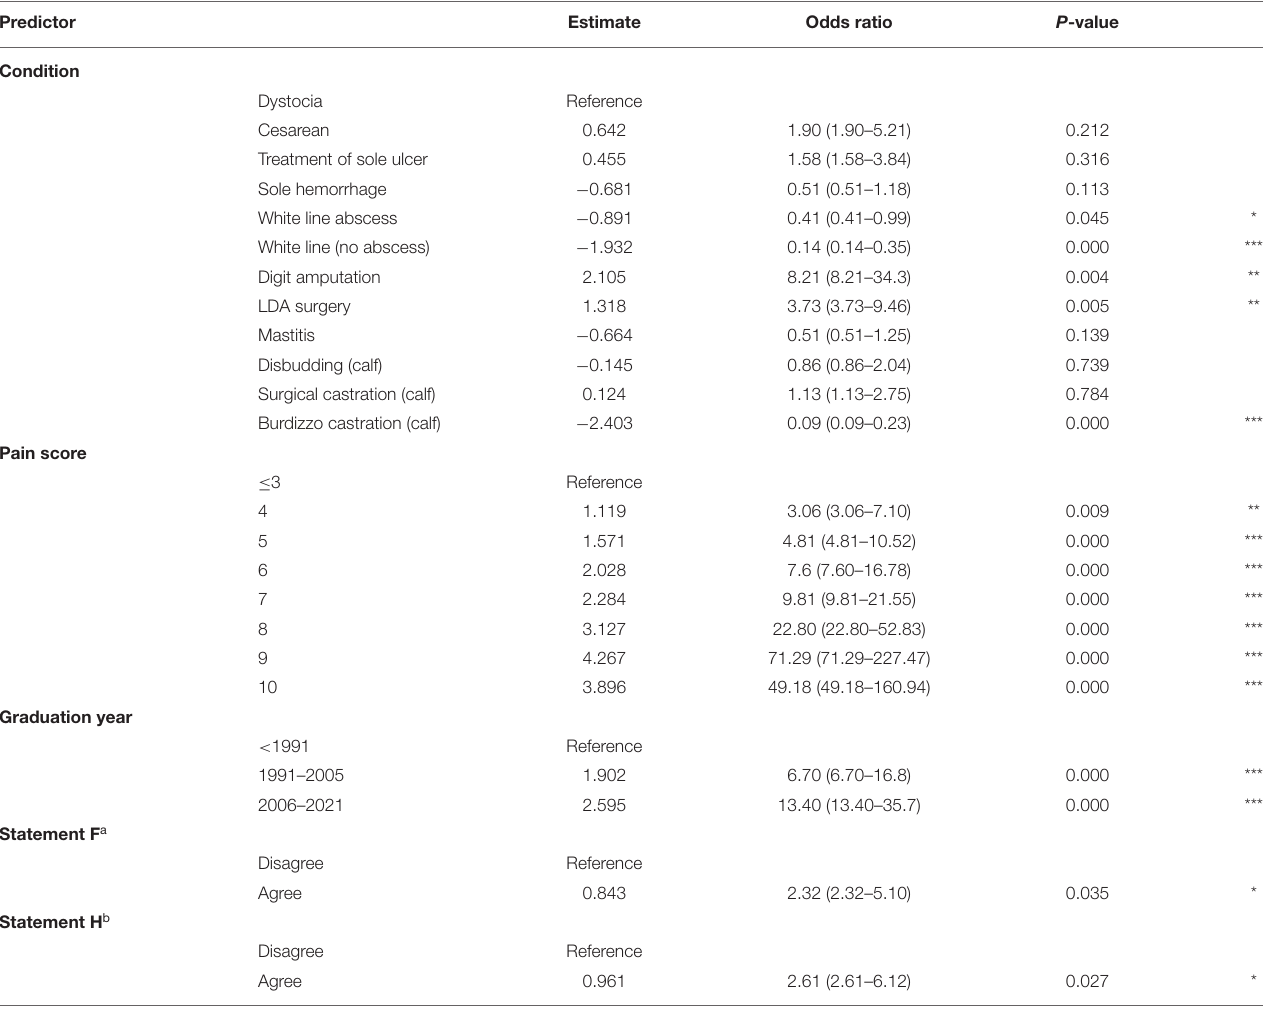
TABLE 4 | Results of a mixed effects logistic regression model that determined factors associated with NSAID use in dairy cows by veterinarians, in a survey investigating attitudes to pain and analgesic use in pasture-based dairy